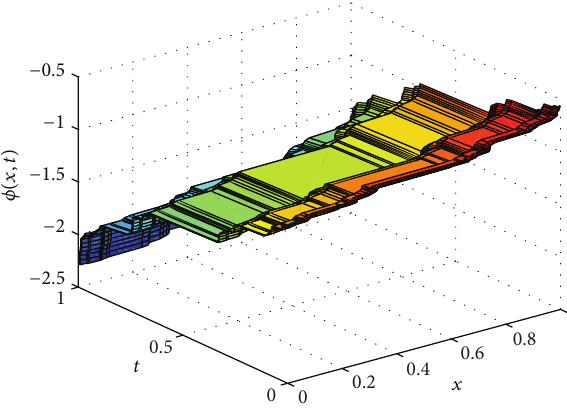
Figure 2: The graph of (1) with the parameters 𝛼 = ln 2/ ln 3 and 𝜇 = 1